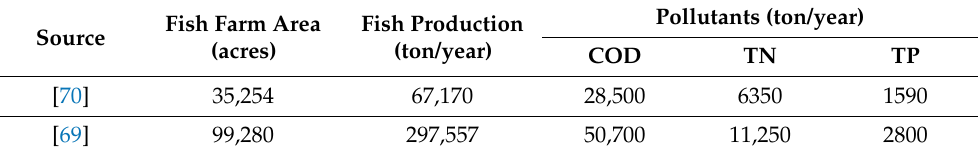
Table 7. Pollution load into Lake Burullus due to fish aquacultural